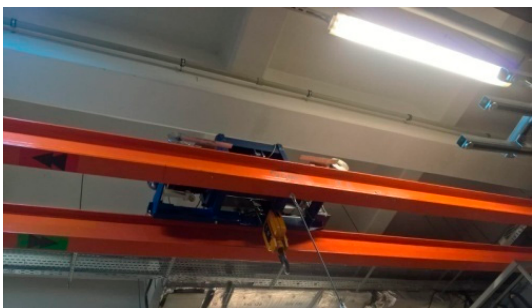
Figure 2. The tested double-girder overhead traveling crane with a trolley and a hoist.